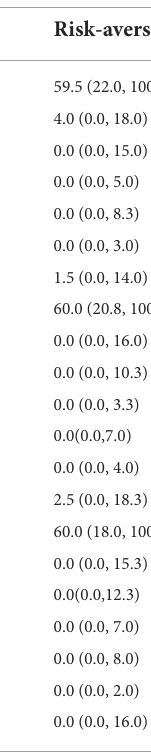
TABLE 10 Description of median household financial asset allocation with different risk attitudes.